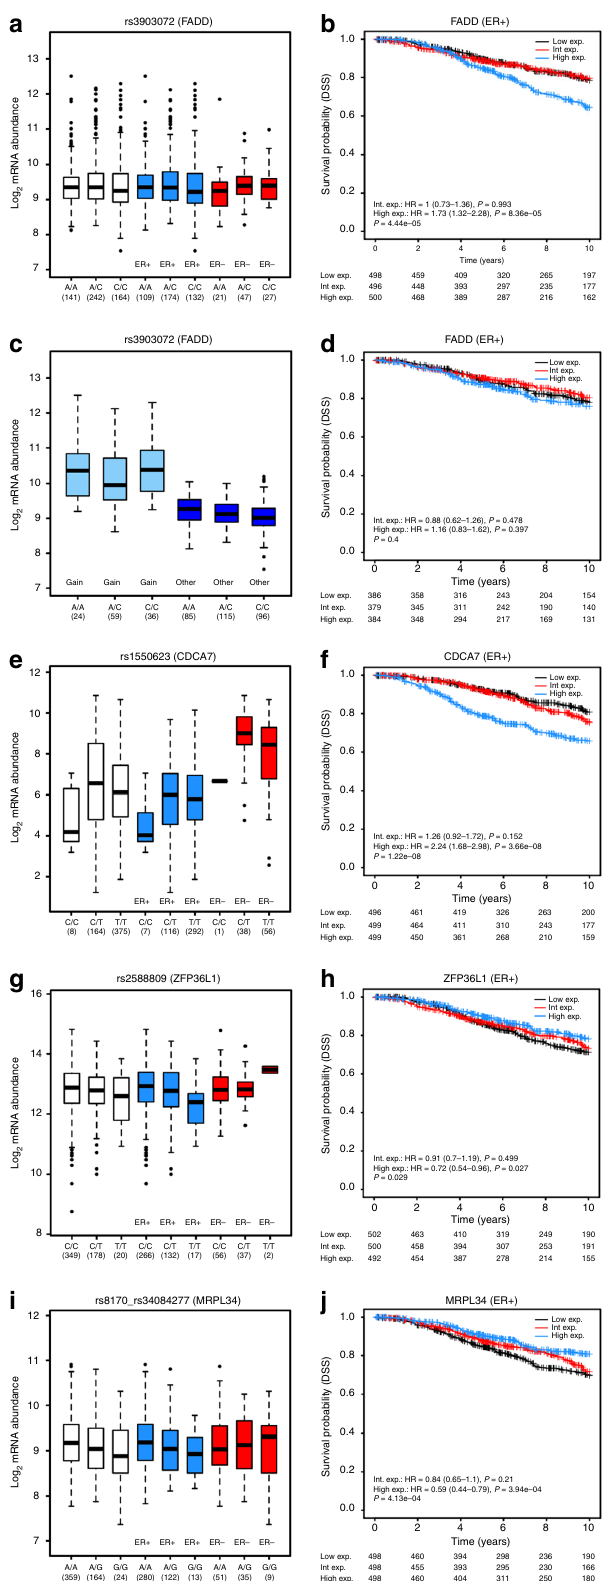
Fig. 5 Box plots of gene expression according to genotype and Kaplan – Meier plots of disease-speci fi c survival according to levels of expression for FADD (11q13), CDCA7 (2q31.1), ZFP36L1 (14q24.1) and MRPL34 (19p13.1). a Levels of expression of FADD are associated with 11q13.1-rs3903072 genotype in all cancers ( P = 0.04) and ER + cancers ( P = 0.01); b in ER + cancers, levels of expression of FADD are also associated with disease-speci fi c survival (DSS) ( c) excluding samples with copy- number gains strengthened the eQTL association in ER + cancers ( P = 0.004) ( d) but attenuated the association with DSS. e , g , i Levels of expression of CDCA7 , ZFP36L1 and MRPL34 are associated with 2q31.1- rs1550623 genotype in all cancers ( P = 0.007), 14q24.1-rs2588809 genotype in ER + cancers ( P = 0.004) and 19p13.1-rs8170 in all cancers ( P = 0.001) and ER + cancers ( P = 0.01), respectively. f , h , j In ER + cancers, levels of expression of all three genes are associated with